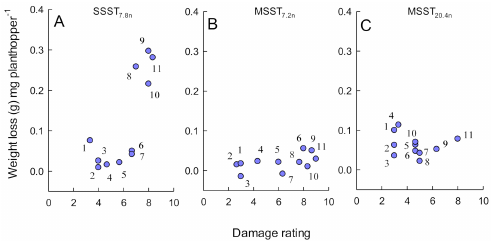
Figure 5. Bi-plots of plant weight loss per unit weight of planthopper estimated from ( A ) Survival 7.8n tests, ( B ) Build-up 7.2n tests and ( C ) Build-up 20.4n tests against damage ratings from equivalent bulk tests (A = SSST 7.8n , B = MSST 7.2n , C = MSST 20.4n ). Numbers are rice lines as follows: 1 =